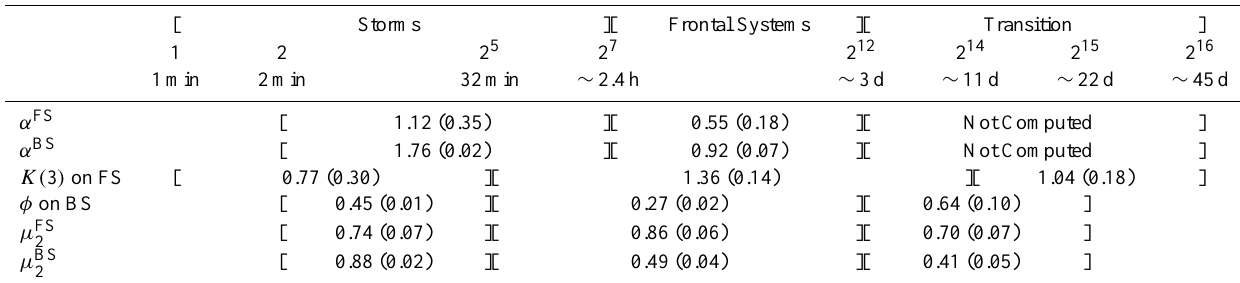
Table 2. Mean and standard deviation (in parentheses) across the 201 gauges of the metrics in the different scaling regimes (separated by square brackets). The breaking points of the time ranges for each metric are reported in the header, where we also indicate the characteristics of the weather phenomena used to interpret the spectra scaling regimes by Fraedrich and Larnder (1993). The metrics have been calculated on FS and/or BS signals constructed with the CC